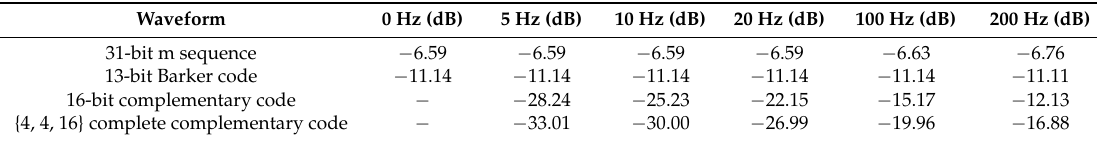
Table 2. Sidelobe peak level of ambiguity function with Doppler shift.